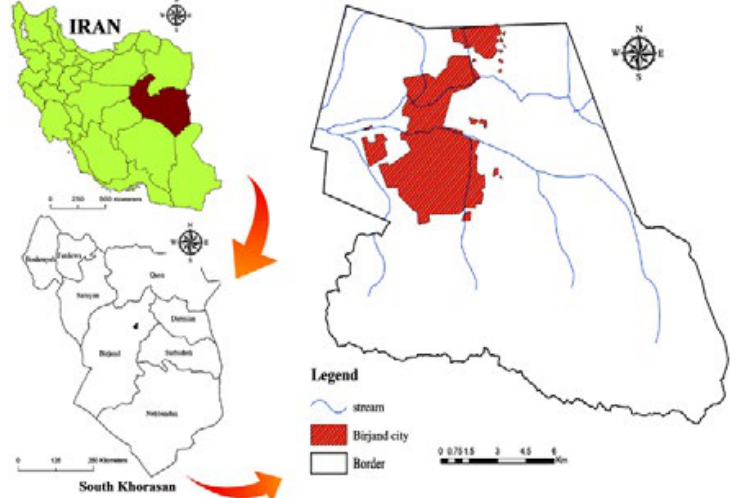
Fig. 1: Geographic location of the study area